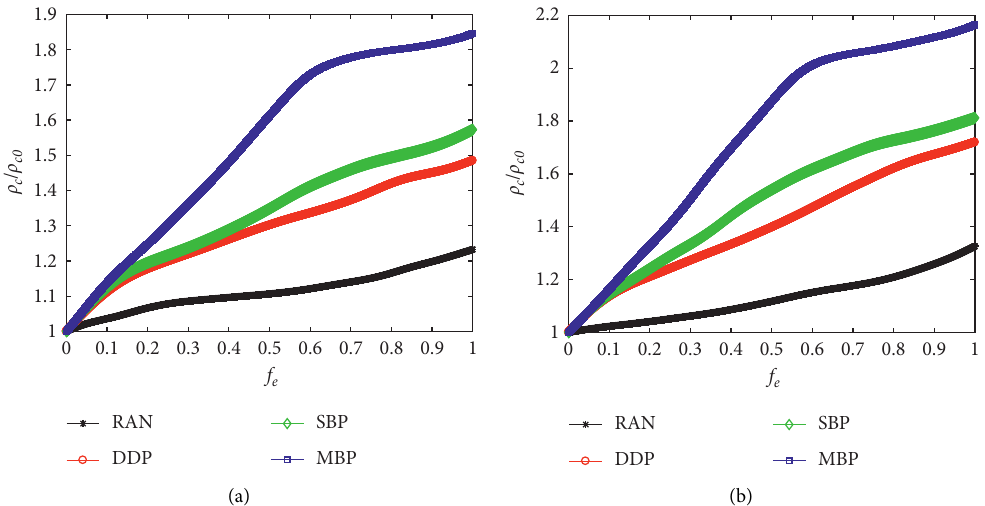
Figure 5: The enhancement of our strategies in multiplex network: (N) � 256, (m) � 8, < (k) > � 32, and (Z) and (b) (Z) in � 28.